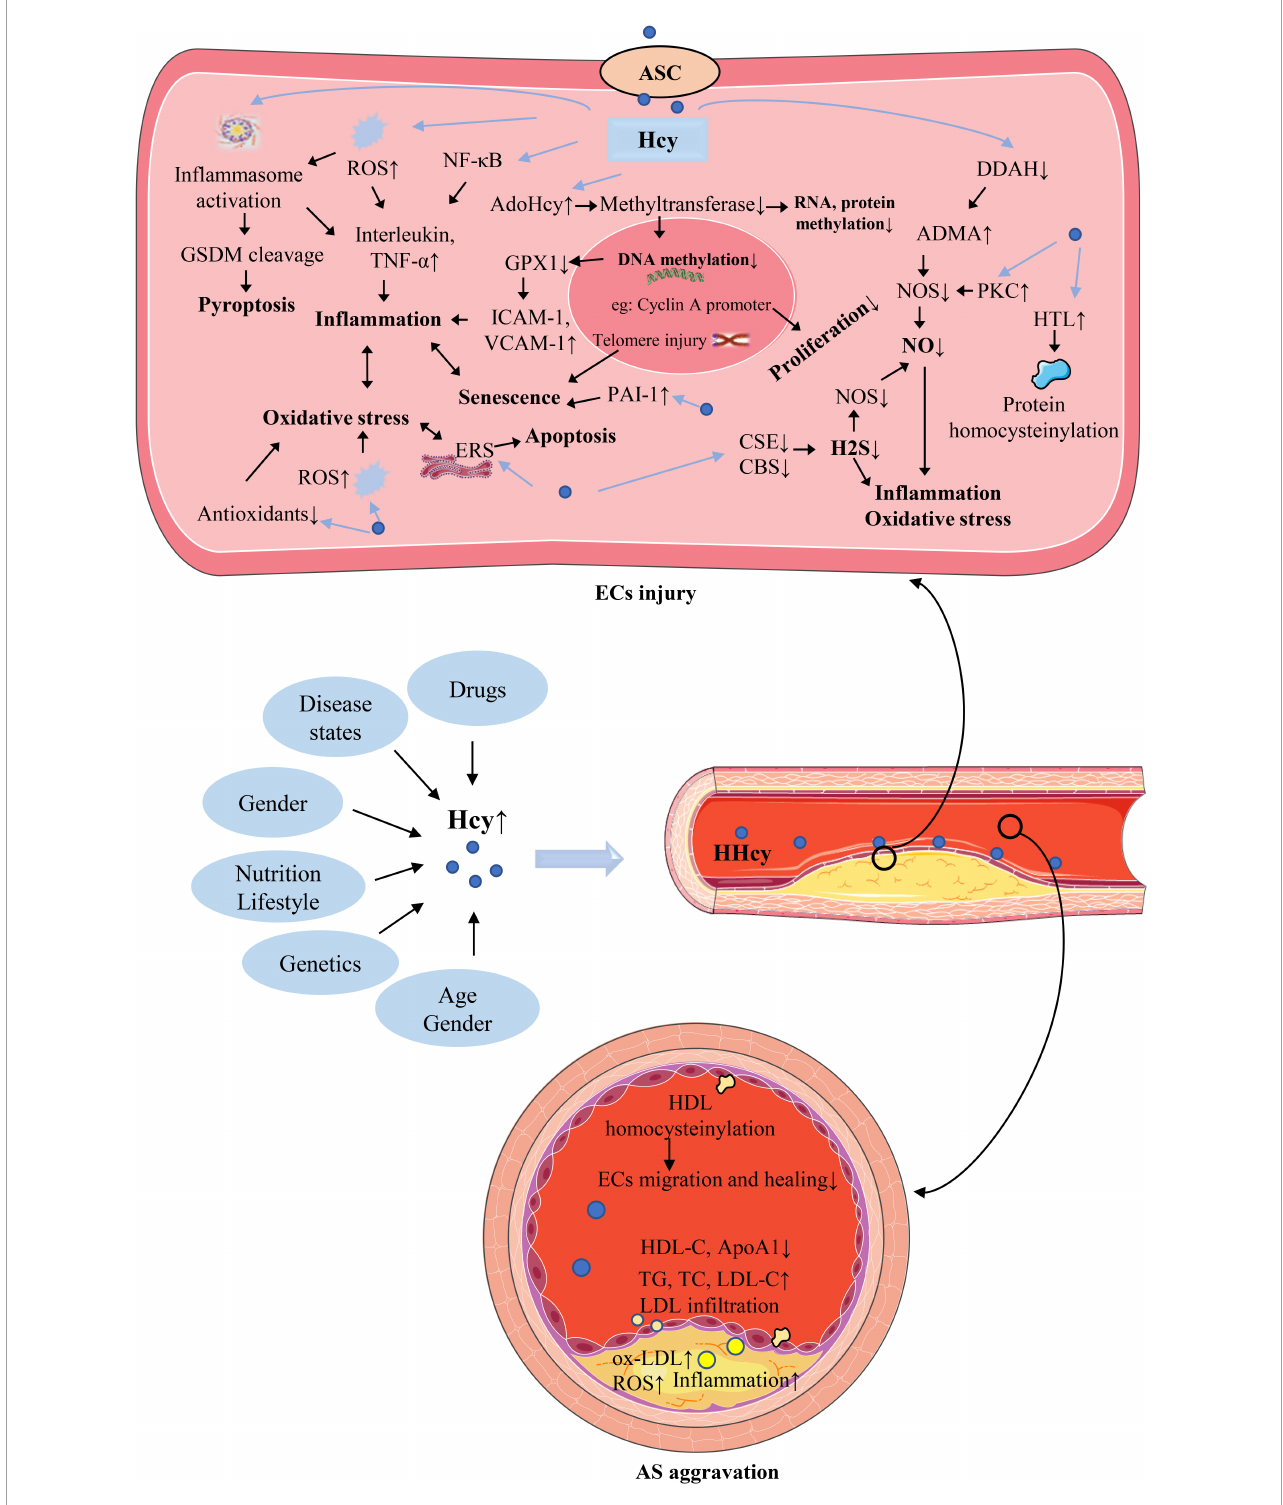
FIGURE2 The causes of hyperhomocysteinemia (HHcy) and the mechanism of homocysteine (Hcy)–mediated endothelial cells (ECs) injury and its consequences for atherosclerosis (AS). The abbreviations in this figure are shown in the “Glossary” section.